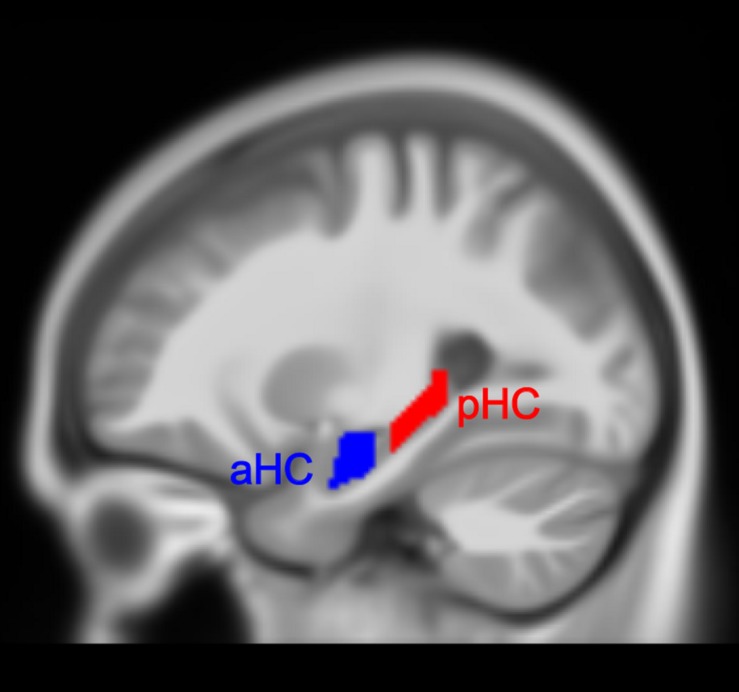
Anterior (aHC) and posterior (pHC) division of the hippocampus.